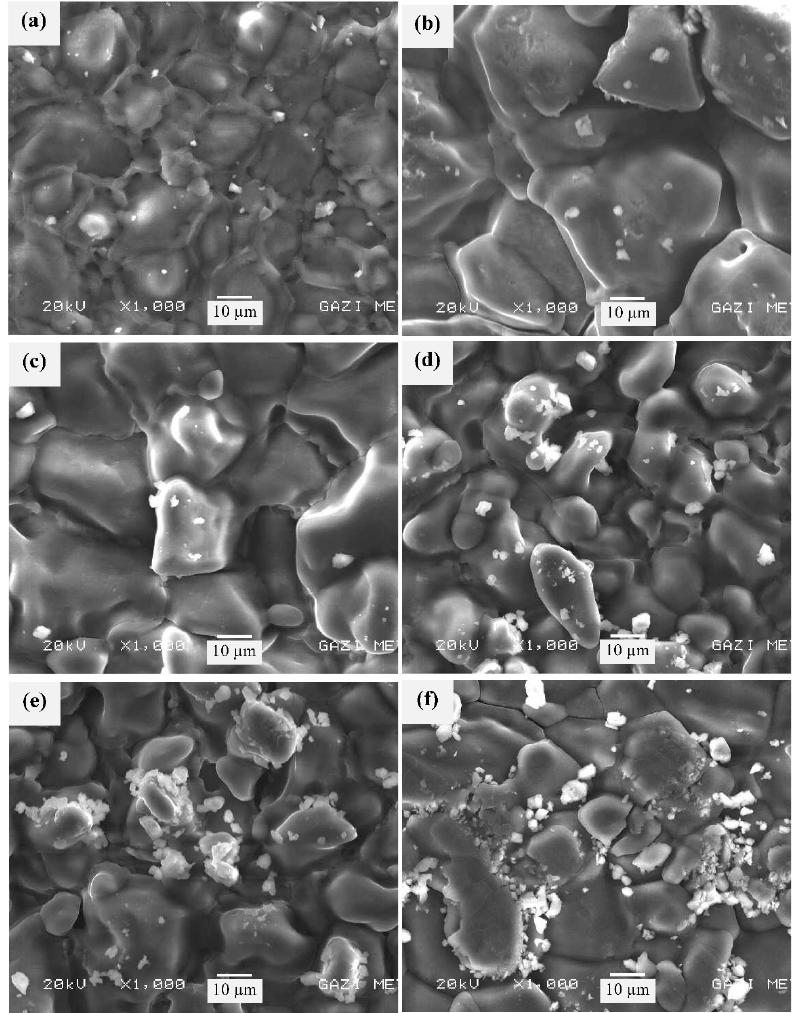
Figure 3. Scanning electron microscope (SEM) micrographs of PVA/NH 4 NO 3 /ZnO NSPEs with different ZnO-NP concentrations: ( a ) NSPE-0, ( b ) NSPE-1, ( c ) NSPE-2, ( d ) NSPE-3, ( e ) NSPE-4, and ( f ) NSPE-5.